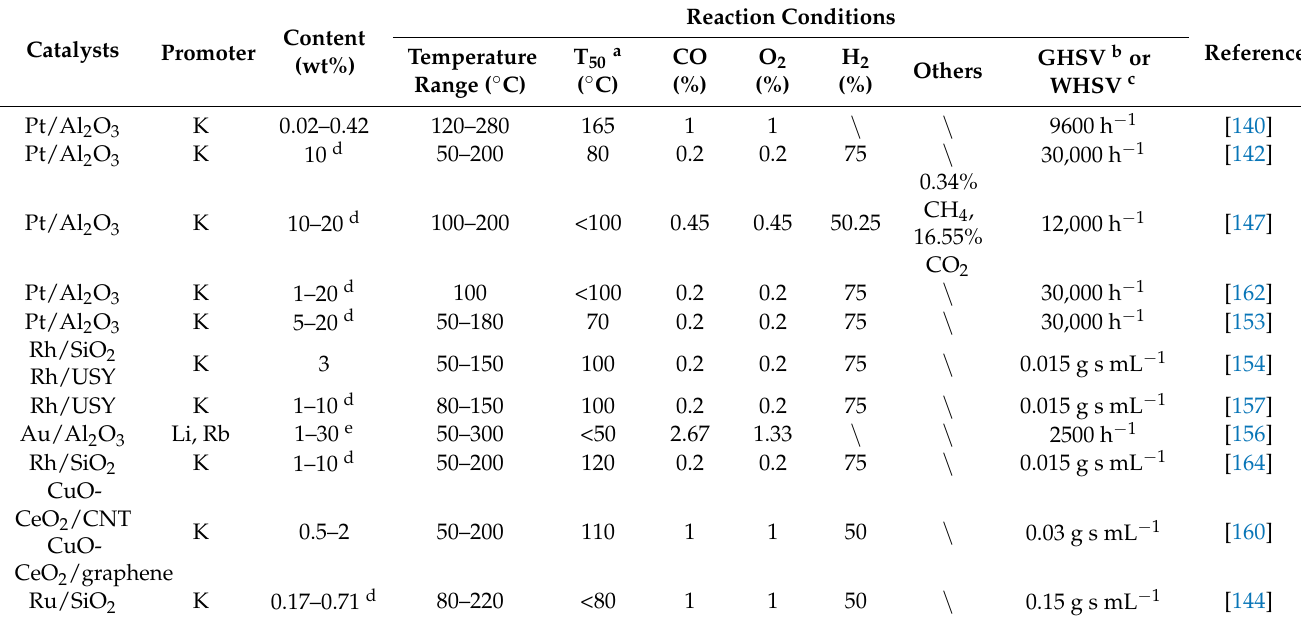
Table 7. Summary of catalysts and reaction conditions for CO oxidation catalysts promoted by alkali metals.